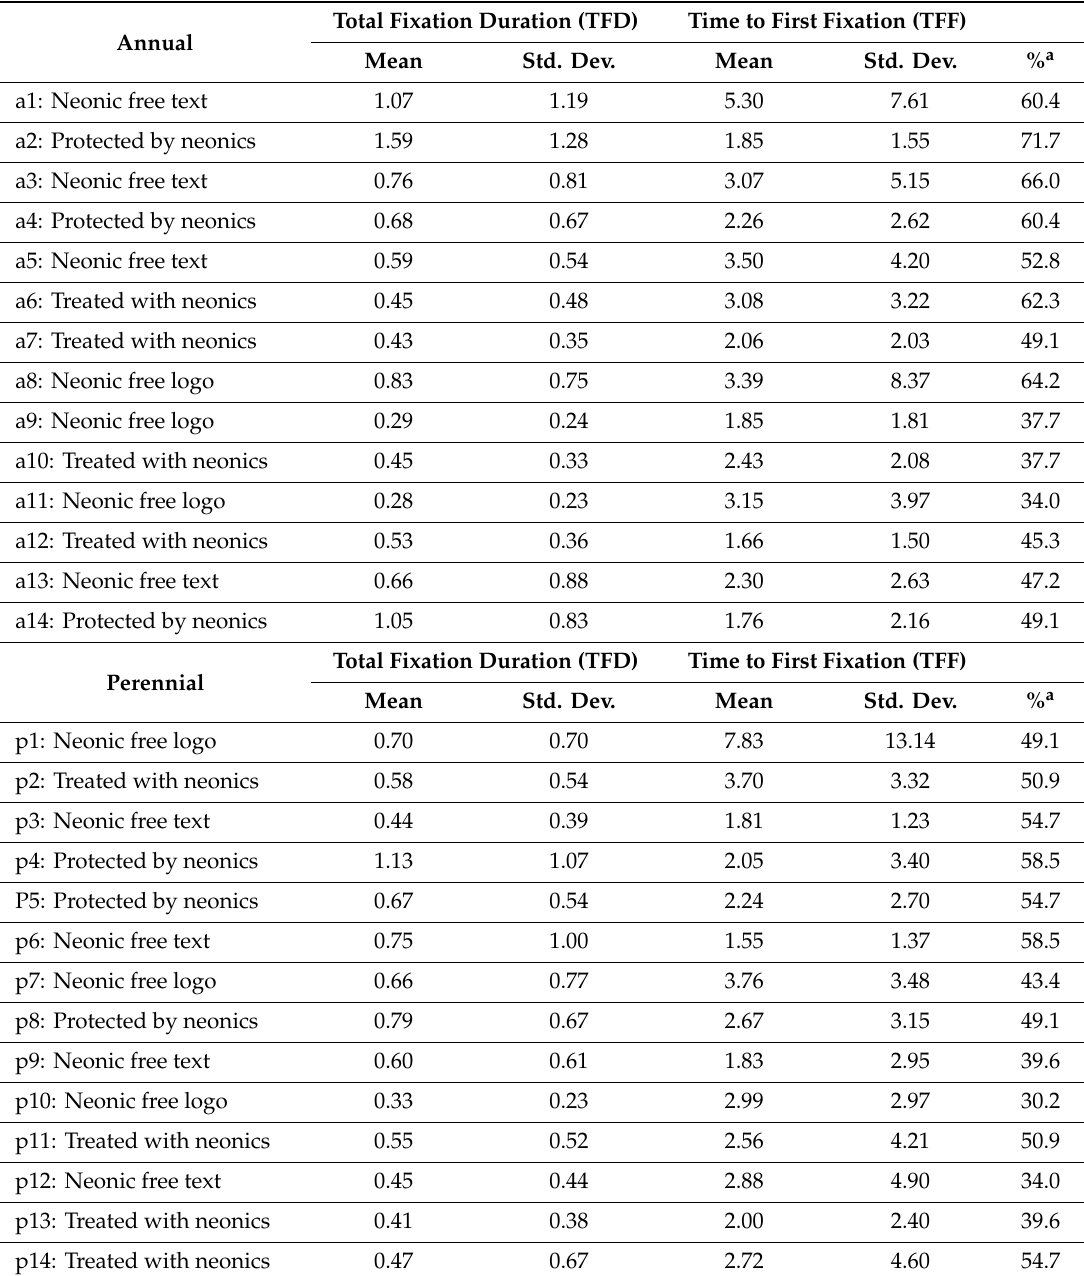
Table A3. Summary of TFD and TFF patterns to neonicotinoid